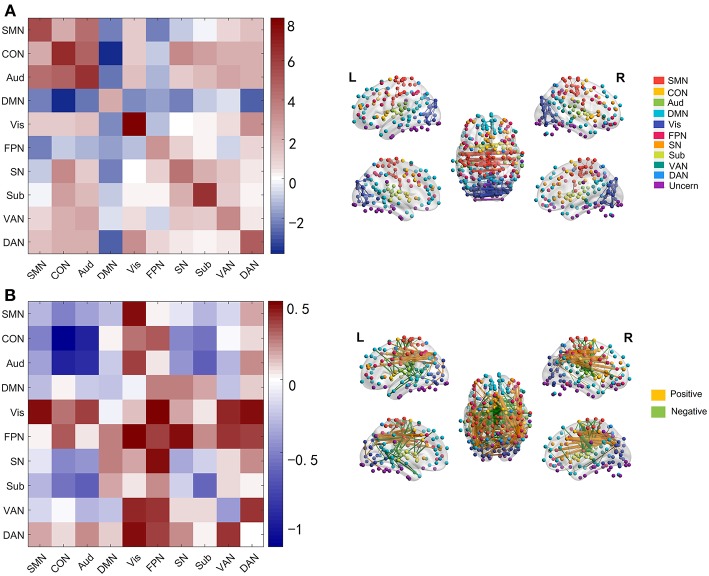
Networks and edges in PC 1 and PC 4. (A) Mean value of edges within and between networks in PC 1(left panel), and edges with absolute value higher than 12 in PC 1 (right panel) which are chosen for convenient viewing. (B) Mean value of edges within and between networks in PC 4 (left panel), and edges with absolute value higher than 1.8 in PC 4 (right panel).